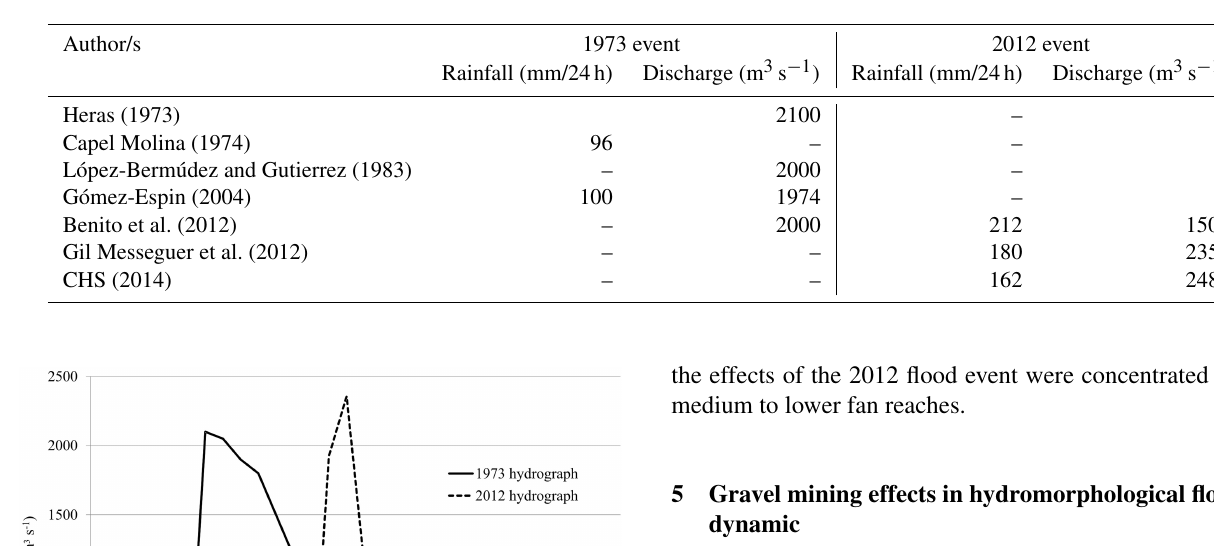
Table 1. Estimated peak discharge and rainfall during the 1973 and 2012 events in the Nogalte channel. Data taken from several sources.